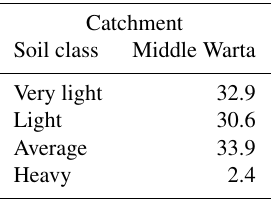
Table 1. Soil class with the percentage of participation in the catch- ment area (source: IUNG, 2009).